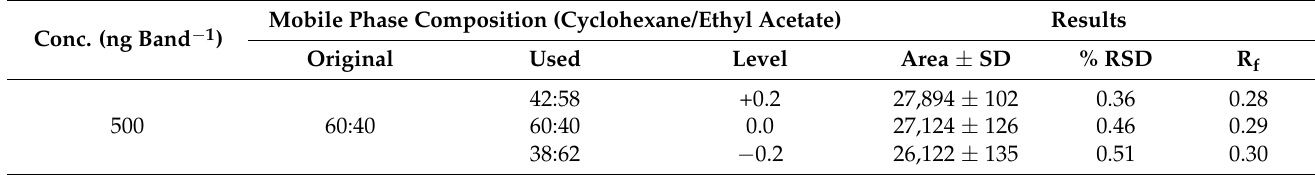
Table 4. Results of robustness evaluation for normal-phase HPTLC technique (mean ± SD; n = 6). Conc. (ng Band − 1